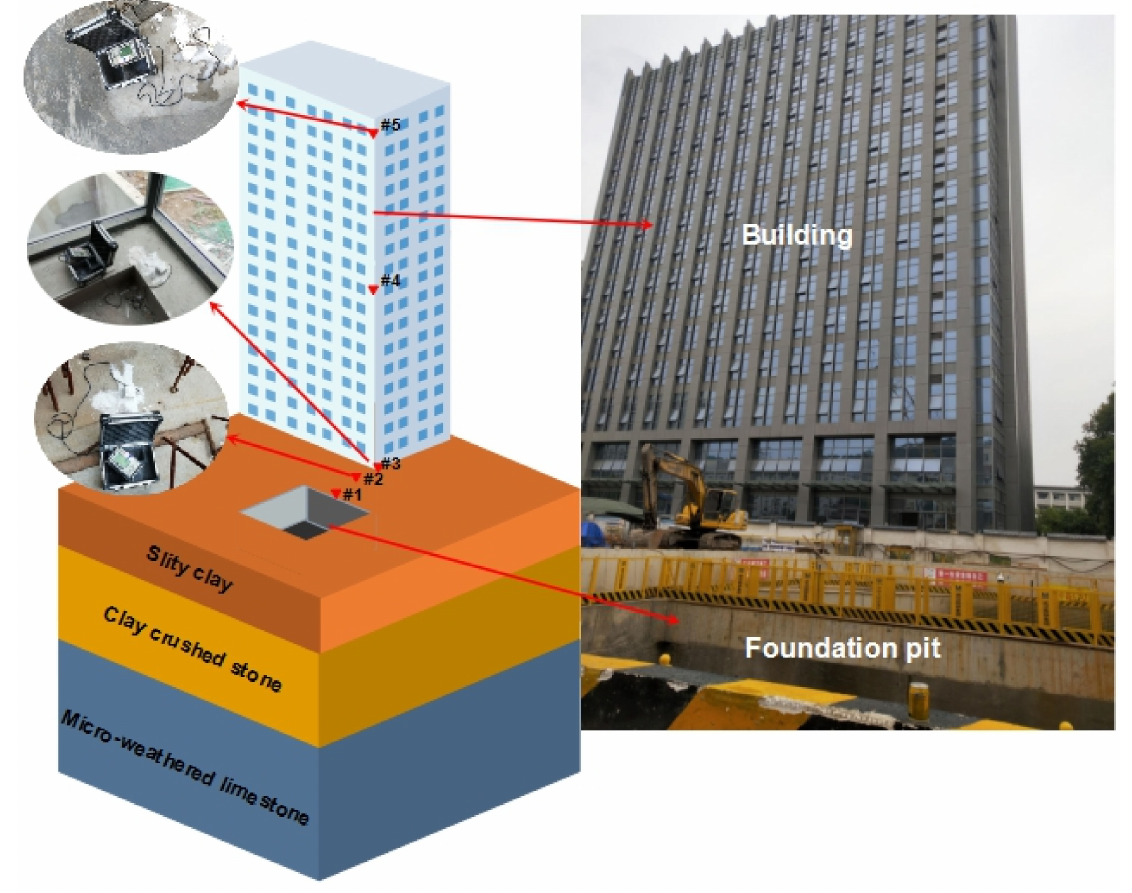
Figure 4. Layout of monitoring